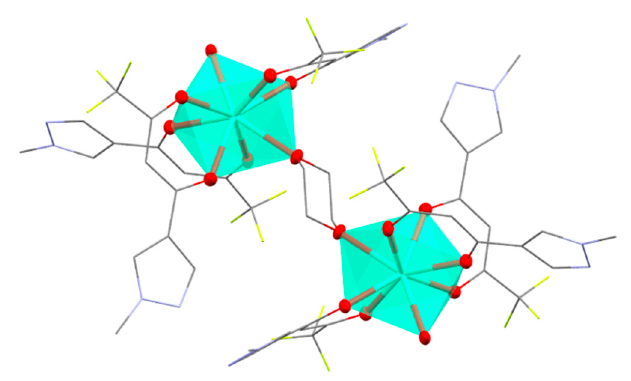
Figure 3. View of Gd 3+ polyhedron in 2 . Dioxane molecules (solvated), hydrogen atoms and thermal ellipsoids of atoms not coordinated to Gd 3+ are omitted for clarity . Table 1. Results of the SHAPE analysis of Gd 3+ polyhedron in 2.